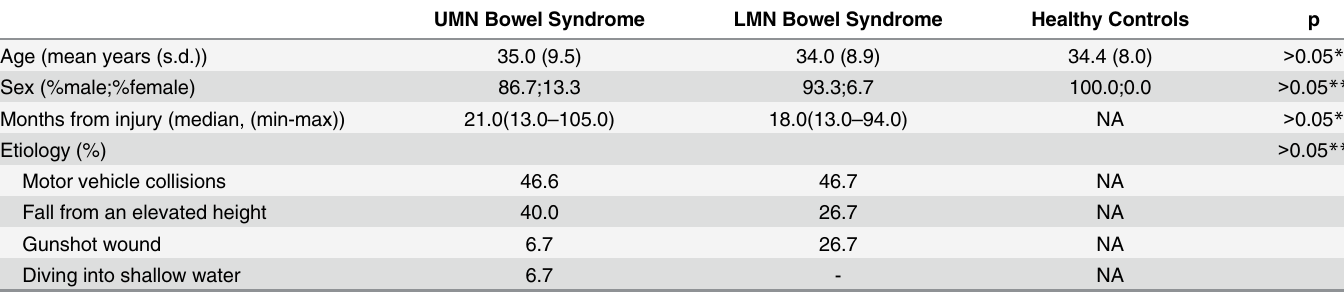
Table 1. Demographic characteristics of the